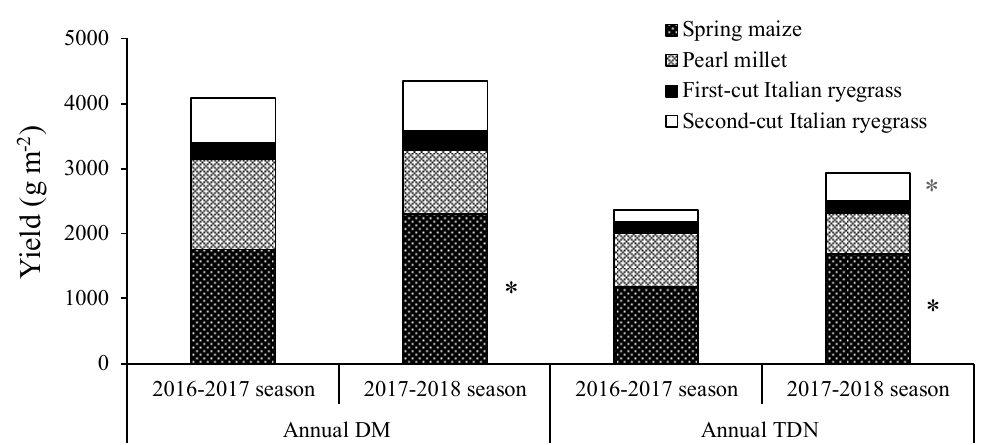
Figure 6. Annual dry matter (DM) and total digestible nutrient (TDN) yields of the triple-cropping system in the 2016–2017 and 2017–2018 seasons. *, p < 0.05.